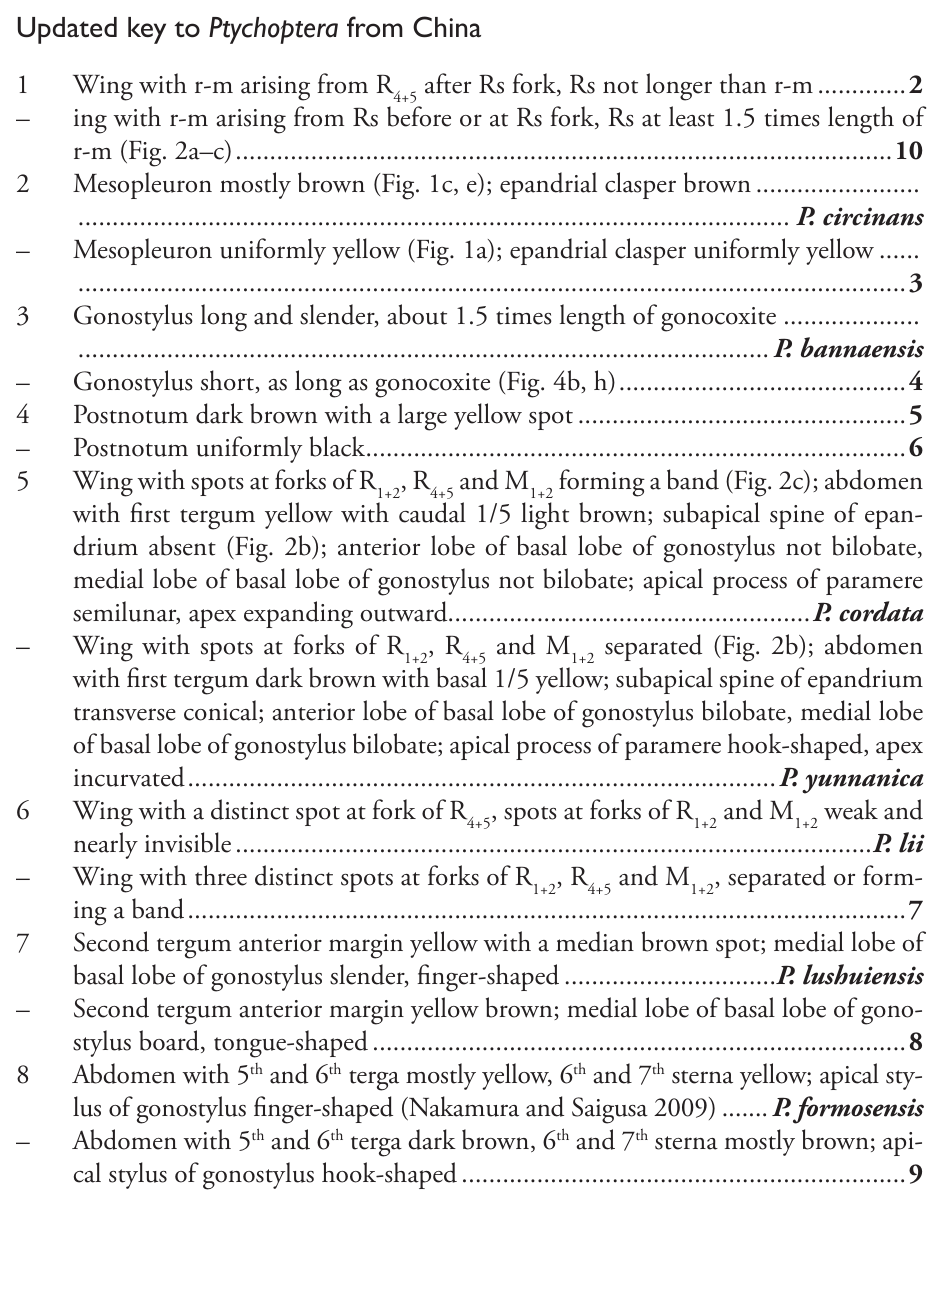
– Second tergum anterior margin yellow brown; medial lobe of basal lobe of gono- Abdomen with 5 th and 6 th terga mostly yellow, 6 th and 7 th sterna yellow; apical sty- lus of gonostylus finger-shaped (Nakamura and Saigusa 2009) ....... P. formosensis – Abdomen with 5 th and 6 th terga dark brown, 6 th and 7 th sterna mostly brown;